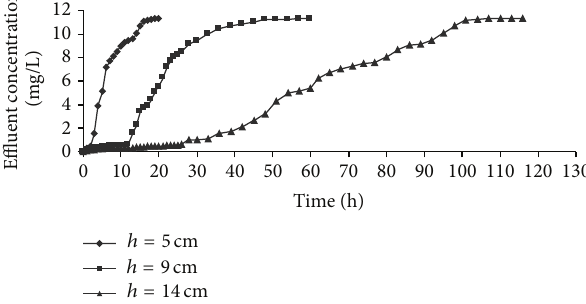
Figure 2: Schematic diagram of laboratory-based small column for fixed bed studies. Figure 3: Effect of bed height on the breakthrough curves for adsorption of lead (flow rate = 6mL/min; initial Pb(II) conc.